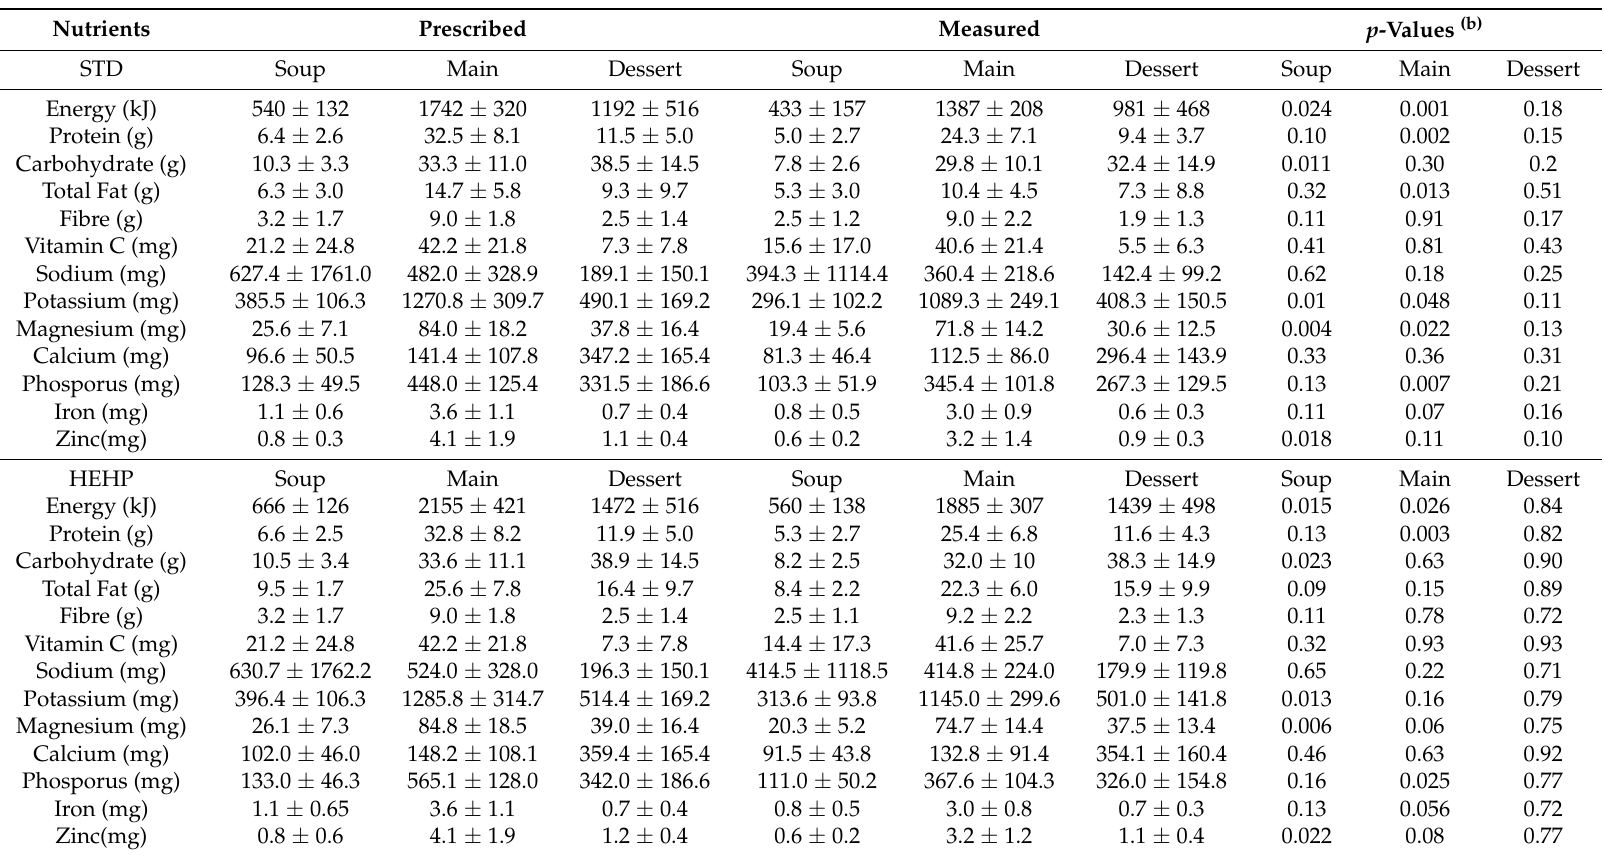
Table 3. Prescribed and measured nutrient contents per serve for soups, mains and desserts within the Standard and High Energy and Protein fortified meals (a).